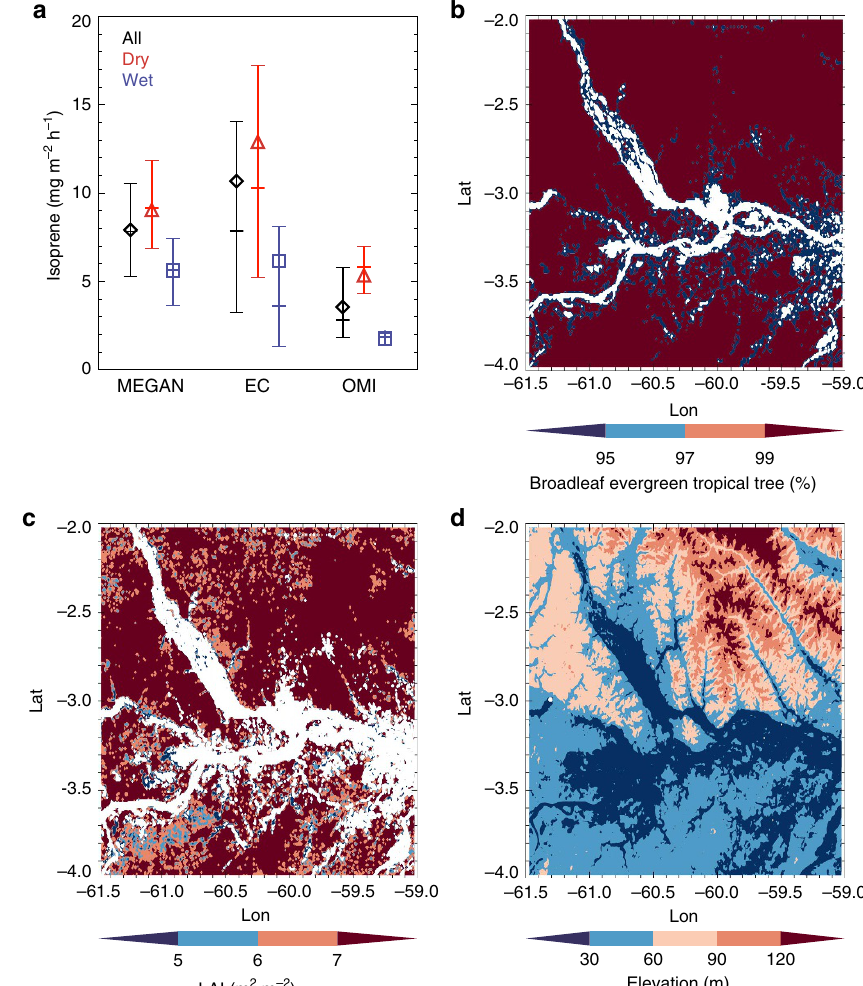
Figure 1 | Isoprene emission estimates and maps of vegetation distributions and terrain elevation. ( a ) Mean values of surface isoprene emissions from MEGAN, EC and OMI for all available flights (black diamond), dry season (red triangle) and wet season (blue square), and their 25% quartile values (lower bar), 50% quartile values (middle bar) and 75% quartile values (higher bar). ( b ) Fractional coverage of broadleaf evergreen tropical trees from MODIS PFT land cover observation. ( c ) Distribution of LAI in September 2014 from MODIS observation. ( d ) Terrain elevation from ASTER Global Digital Elevation